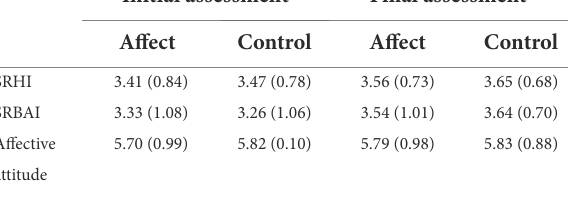
TABLE 2 Means and standard deviations by condition over time ( N =